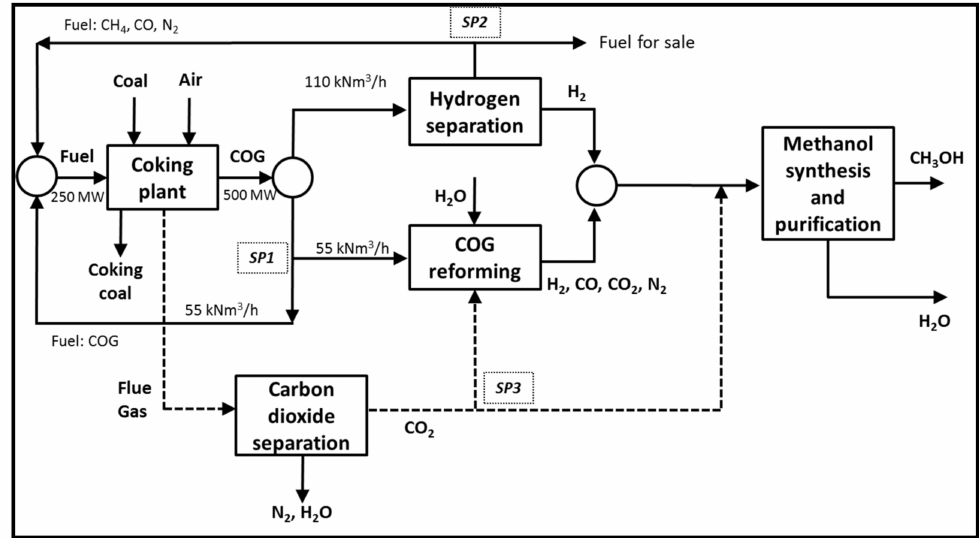
Figure 1. Simplified process structure to produce methanol from COG and flue gases (SP1, SP2, and SP3 are splitters to adjust flowrates in each process unit, black circles represents logical operators to select a process case